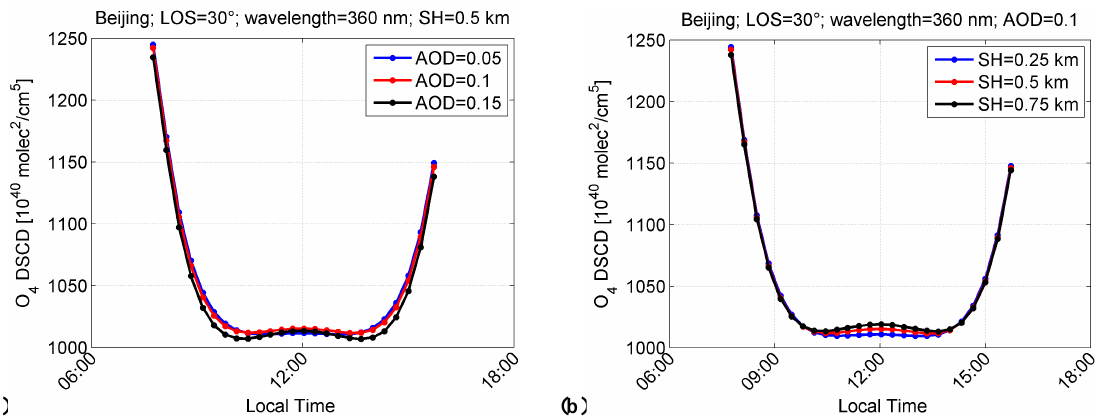
Fig. 3. Diurnal variation of simulated O 4 DSCDs at 30 ◦ elevation at 360nm for an aerosol profile exponentially decreasing with altitude: (a) With a scaling height of 0.5km for different aerosol optical depths (0.05–1.5) and (b) with an aerosol optical depth of 0.1 and different scaling heights